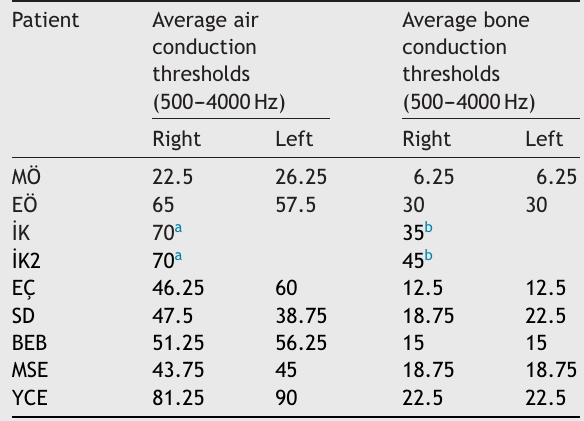
Air and bone conduction thresholds of patients with MPS (dB